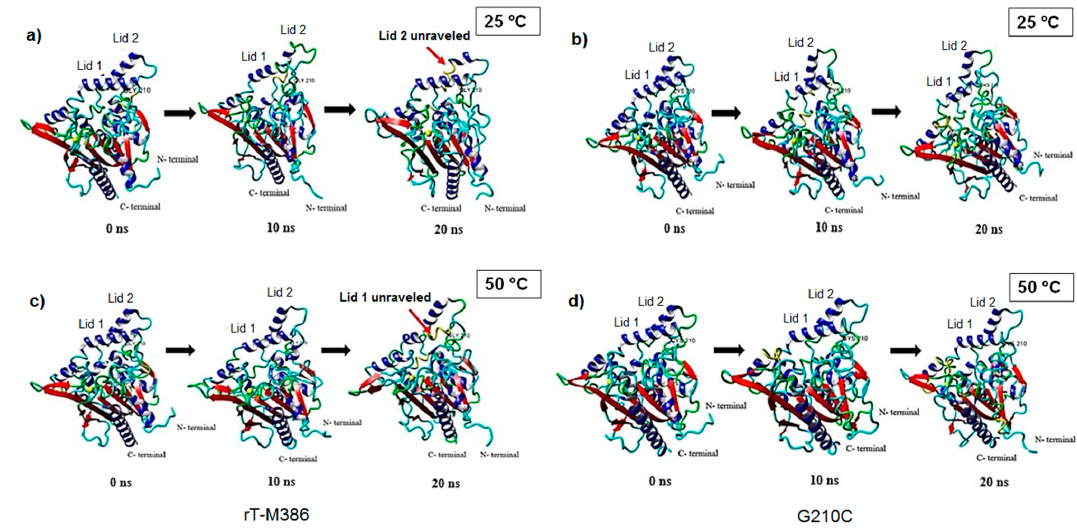
Figure 8. The snapshots of rT-M386 and G210C models at 0, 10 ns and 20 ns simulations. ( a ) rT-M386 at 25 ◦ C; ( b ) G210C at 25 ◦ C; ( c ) rT-M386 at 50 ◦ C; and ( d ) G210C at 50 ◦ C. The α -helices in the lid region of rT-M386 started to unravel at both temperatures towards the end of simulations. The α -helices, β -strands, 3 10 -helix, turn and loops are shown in blue, red, yellow, green, and cyan colors, respectively. Residues of Gly / Cys 210, lids and N- and C- termini are labeled, accordingly. Models are generated by YASARA in linear ribbon.